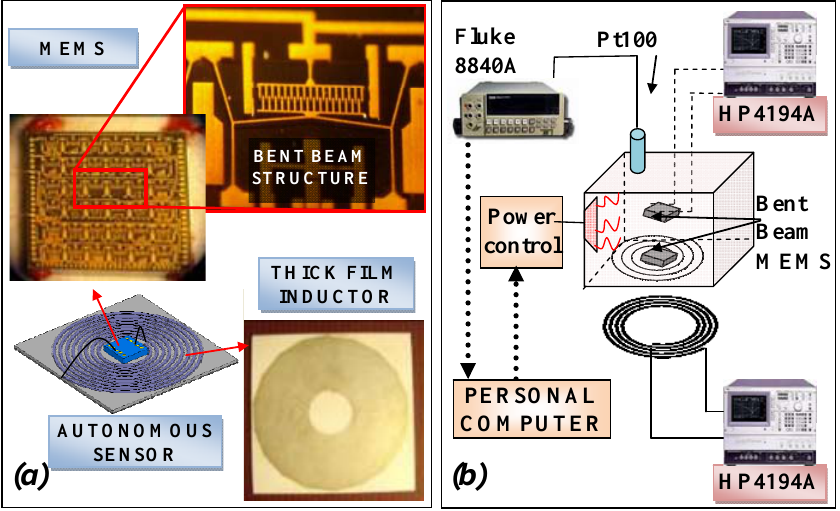
Figure 7. (a) Sketch of the passive autonomous sensor for high temperature measurement and (b) block diagram of the experimental